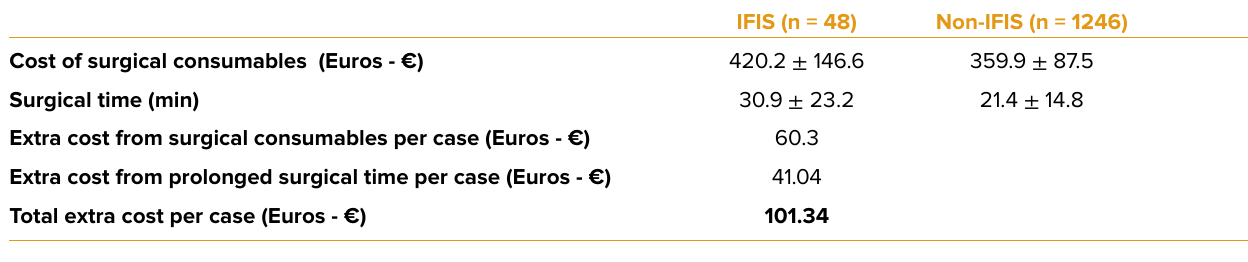
Cost of surgical consumables (Euros - €)